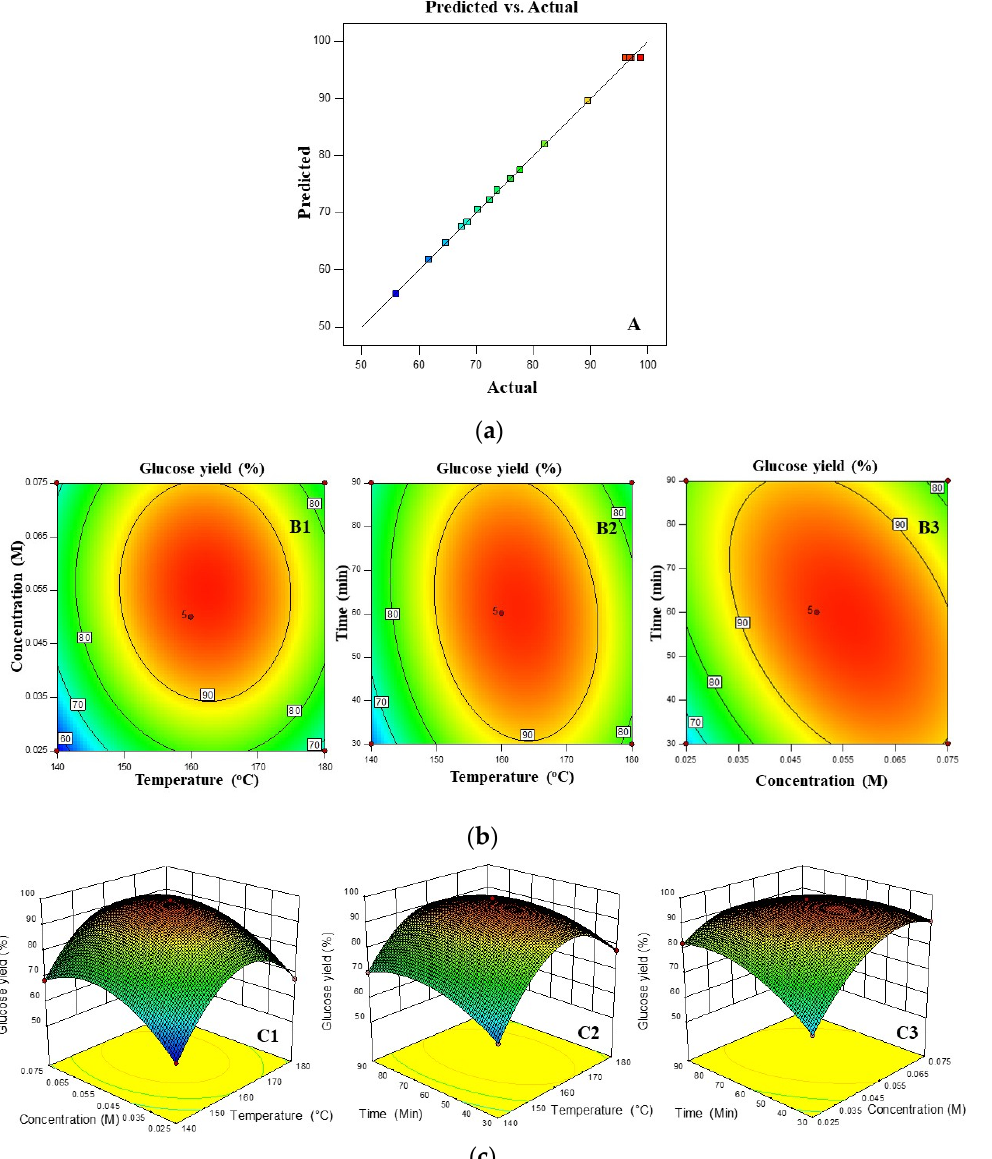
Figure 1. Response surface plot of the LHW pretreatments process: Effect of reaction time (30–90 min), acid concentration (0.025 M–0.075 M) and temperature (140–180 °C) on glucose yield ( a ) Pre- dicted vs. actual data plot ( b ) 2D contour plot ( c ) 3D surface plot on glucose yield under optimiza- tion.